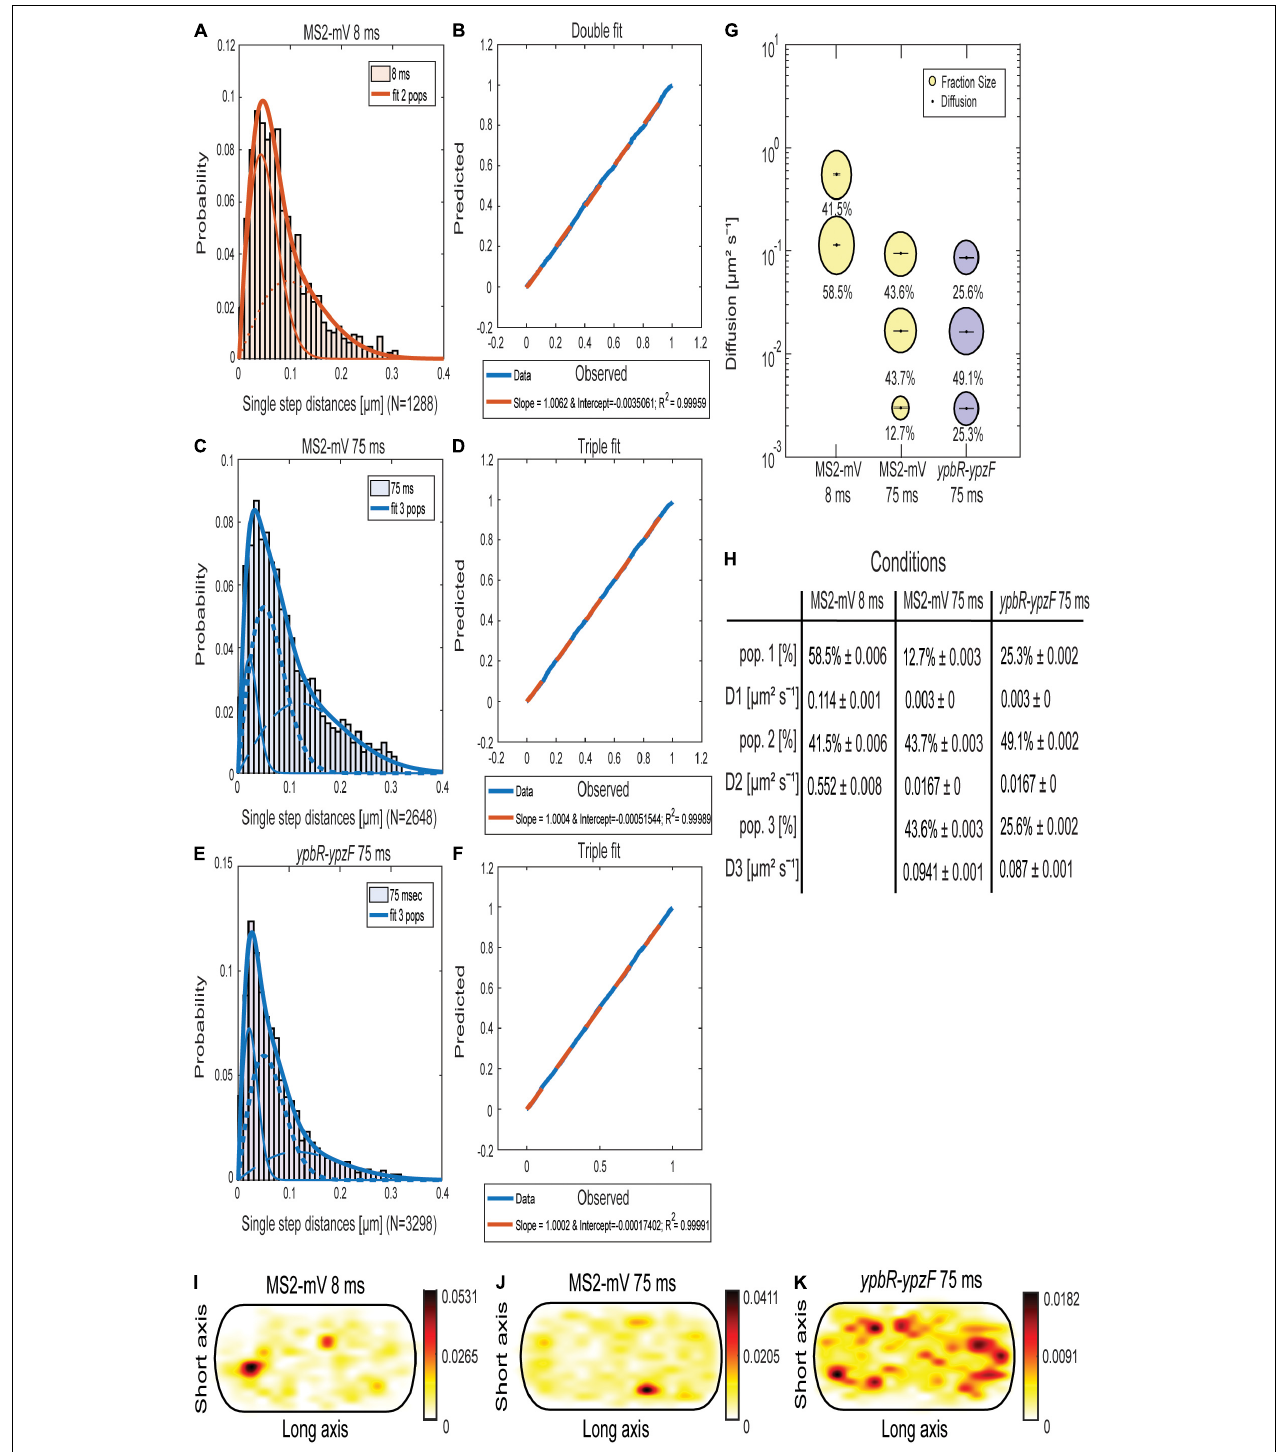
FIGURE 1 | Analyses of single-molecule dynamics of MS2-mVenus expressed in B. subtilis cells during exponential growth. (A,C,E) Jump distance analysis shows probability of displacements 8-ms acquisition (A) or 75-ms acquisition (C,E) . (B,D,F) Probability–probability plot displays the goodness of fit of predicted (red dotted lines) and determined data (blue solid lines). Triple Rayleigh fit models are shown in blue; double fits are depicted in red. Different dotted lines represent the subpopulations; solid lines represent the sum of the subpopulations. (G) . Bubble plot shows the size of the fractions (proportional to the area) and corresponding diffusion coefficients. MS2-mVenus only is shown in yellow, in the presence of ypbR-ypzF carrying two binding sites in purple. (H) Table showing population size (pop.) and diffusion constants “D” of MS2-mV only at two different acquisition times, and of specifically tagged ypbR-ypzF mRNA. (I–K) Heat maps for MS2-mVenus tracked with 8 ms (I) , 75 ms (J) , and in the presence of tagged ypbR-ypzF mRNA. White to red: low to high probability of distribution of tracks.